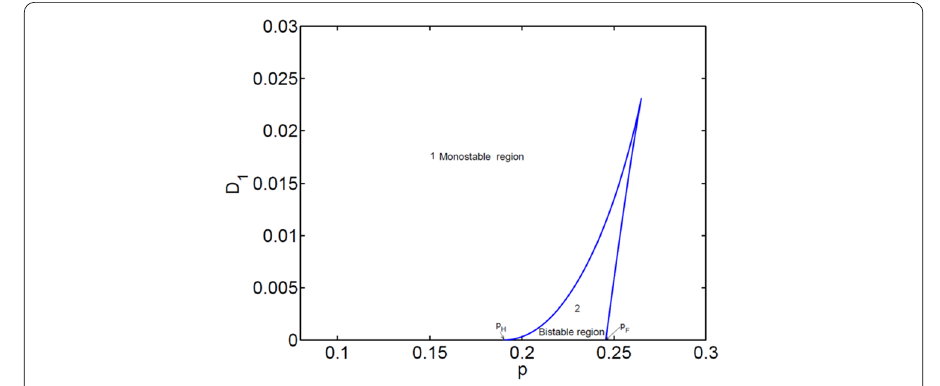
Figure 5 Transition set curves under additive noise excitation (taking p and D 1 as unfolding